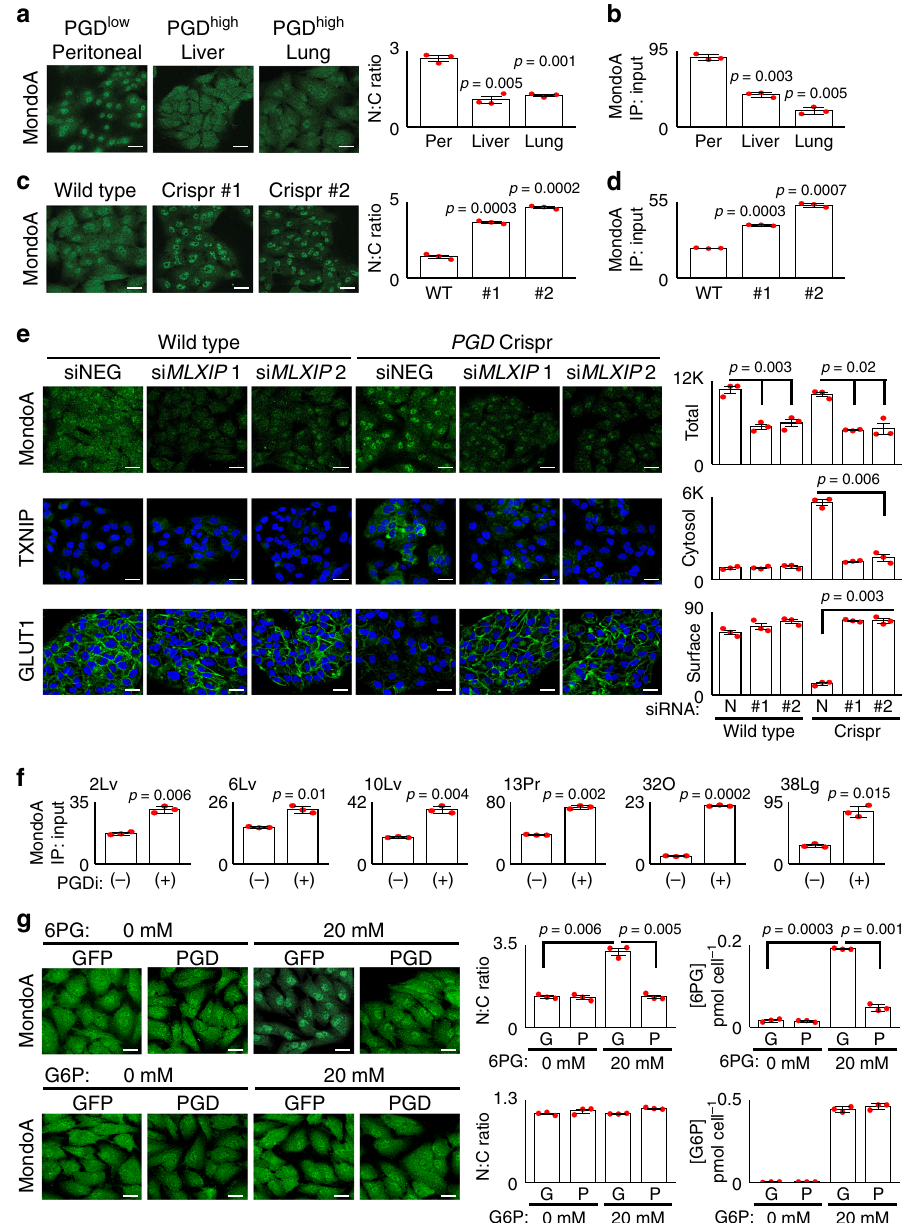
Fig. 4 PGD status in fl uences MondoA traf fi cking. a MondoA was concentrated in the nucleus of PGD low 38Per peritoneal control cells by IF (left panel). In contrast, MondoA was distributed more equally between the nuclei and cytosol in PGD high liver and lung metastases from the same patient (38Lv, 38Lg). b ChIP assays also detected reduced MondoA enrichments at the TXNIP promoter in the liver and lung metastases. c PGD inactivation by Crispr/ Cas (sgRNAs #1, #2) concentrated MondoA into the nucleus of PGD high 38Lg cells, as compared to wild-type controls. d PGD Crispr/Cas also increased MondoA enrichments at the TXNIP promoter by ChIP assays in 38Lg. e siRNAs targeting MondoA (si MLXIP #1, #2) knocked down MondoA in 38Lg cells (top panels) and prevented upregulation of TXNIP during Crispr/Cas PGD inactivation (middle panels). MondoA knockdown also rescued surface GLUT1 (bottom panels). f ChIP assays detected increased MondoA enrichments at the TXNIP promoter across the indicated PGD high subclones treated with PGD inhibitor (PGDi: 6AN). g (Top panels) Treatment of GFP-expressing PGD high 38Lg cells with excess (20 mM) 6PG concentrated MondoA in the nucleus by IF. This effect was rescued by depleting the excess 6PG with PGD overexpression 4 . Measurements of intracellular 6PG concentrations (right plots) con fi rmed that 6PG accumulated in treated GFP-expressing cells and that the excess was depleted in exogenous PGD-(over)expressing cells. Bottom panels: G6P control treatments failed to concentrate MondoA into the nucleus under any condition. For IF experiments: green, antibody signal; blue, Hoechst signal; n = 3 biological replicates, error bars: s.e.m., indicated p values calculated by two-tailed t tests, scale bars: 20 µ m. For ChIP experiments: n = 3 technical replicates, error bars: s.d.m., indicated p values calculated by two-tailed t tests, results are representative of two biological